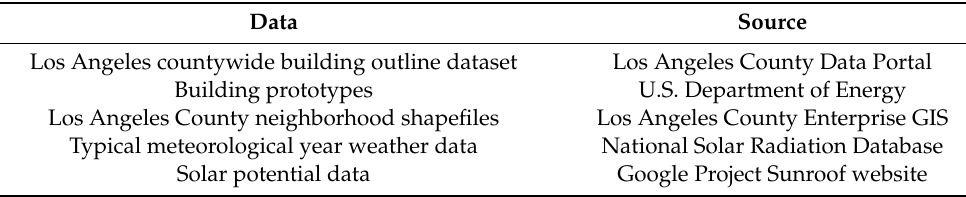
Table 1. Datasets used in this study and data